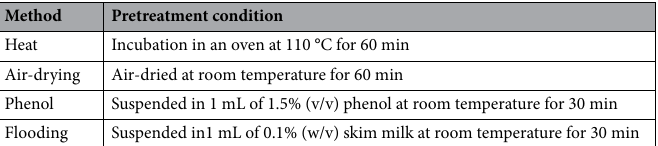
Table 4. Pretreatment